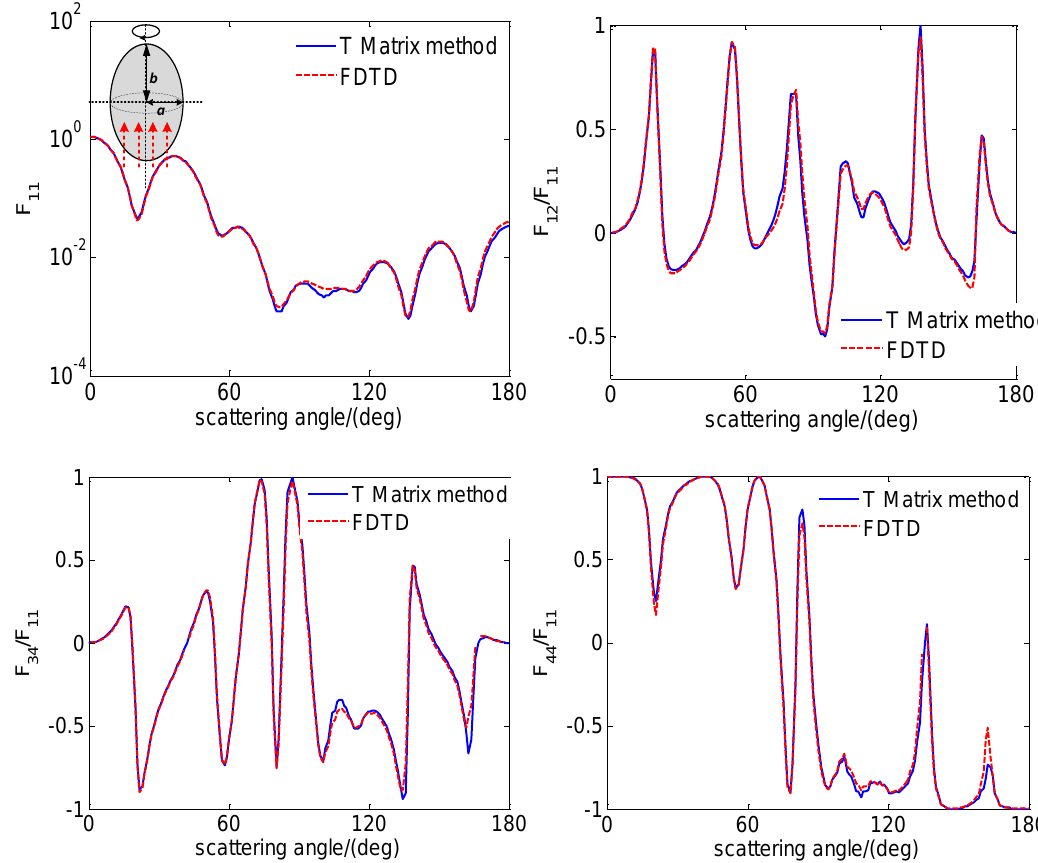
Figure 3. Comparison of the Müeller Matrix simulated by T Matrix method and parallel FDTD model for spheroid particle. Overall, the Müeller matrix curve obtained by the FDTD model coincides with that simulated by T matrix method in the scattering angle range from 0° to 180°. In the forward scattering direction (0 ~90°), The average relative errors of F 11 、 F 12 、 F 34 and F 44 are only 3.1%, 4.2%, 3.3% and 3.5% respectively. In the backward scattering direction, the simulation accuracy of Müeller matrix is slightly lower, especially in the region where the matrix elements vary sharply with the scattering angle, the simulation curve of FDTD might deviate from the result of T matrix method.